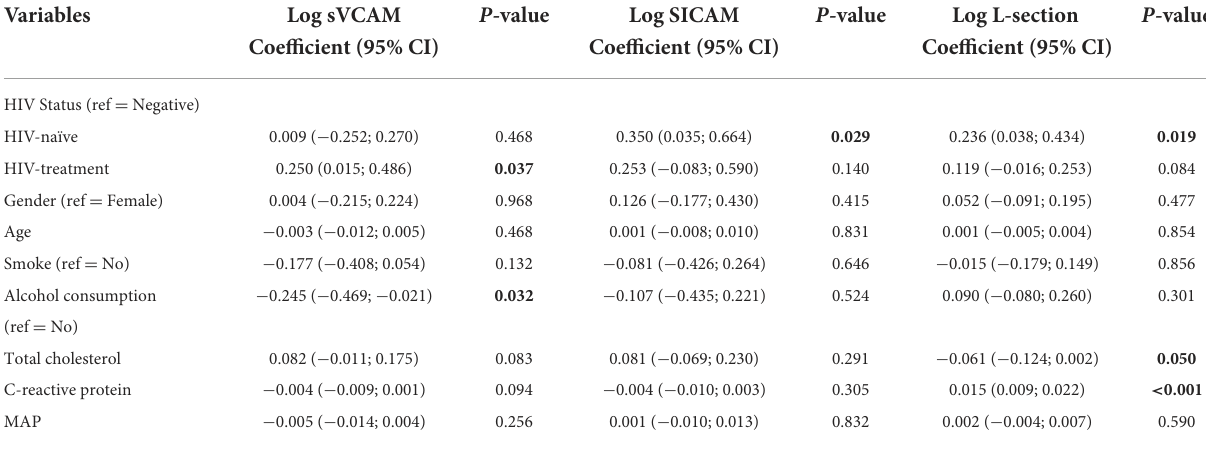
TABLE 5 Adjusted multivariate analysis between endothelial biomarkers (sVCAM, sICAM and L-section) and CVD risk factors for the entire study participants).